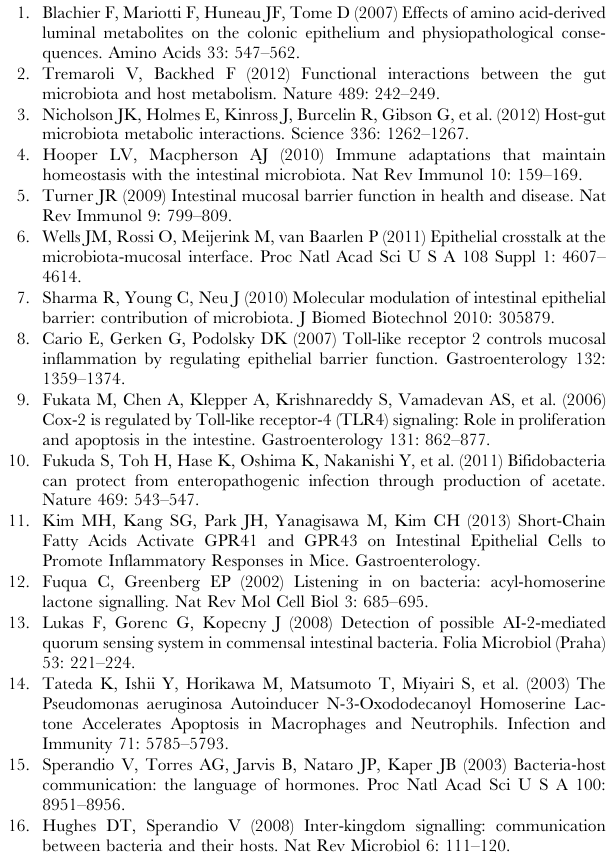
Figure S1 The mRNA expression levels of various molecules related to TJ and AJ in the epithelium of small intestines in GF mice. Real-time quantitative RT-PCR analysis of mRNA expression of Cldn7, Ocln, Tjp1, Ctnnb1, Cdh1 in the epithelium of small intestines in SPF (n =4) or GF (n= 4) mice. Values were normalized to that of Gapdh . Data are representative of two independent experiments and show mean values 6 S.D. of 4